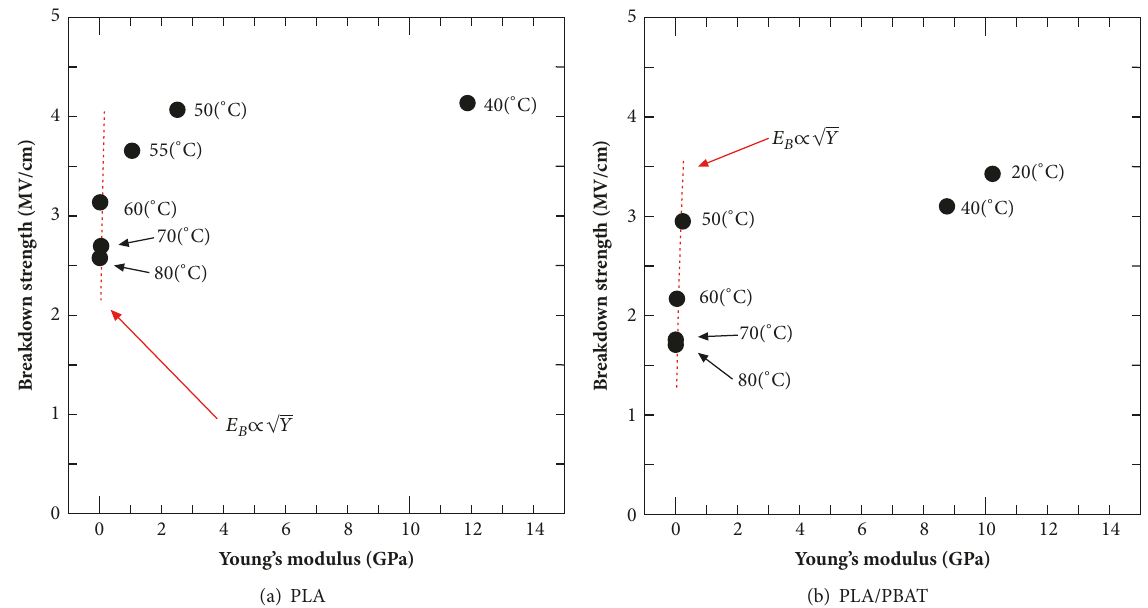
Figure 12: Relation between 𝐸 𝐵 and Young’s modulus of PLA and